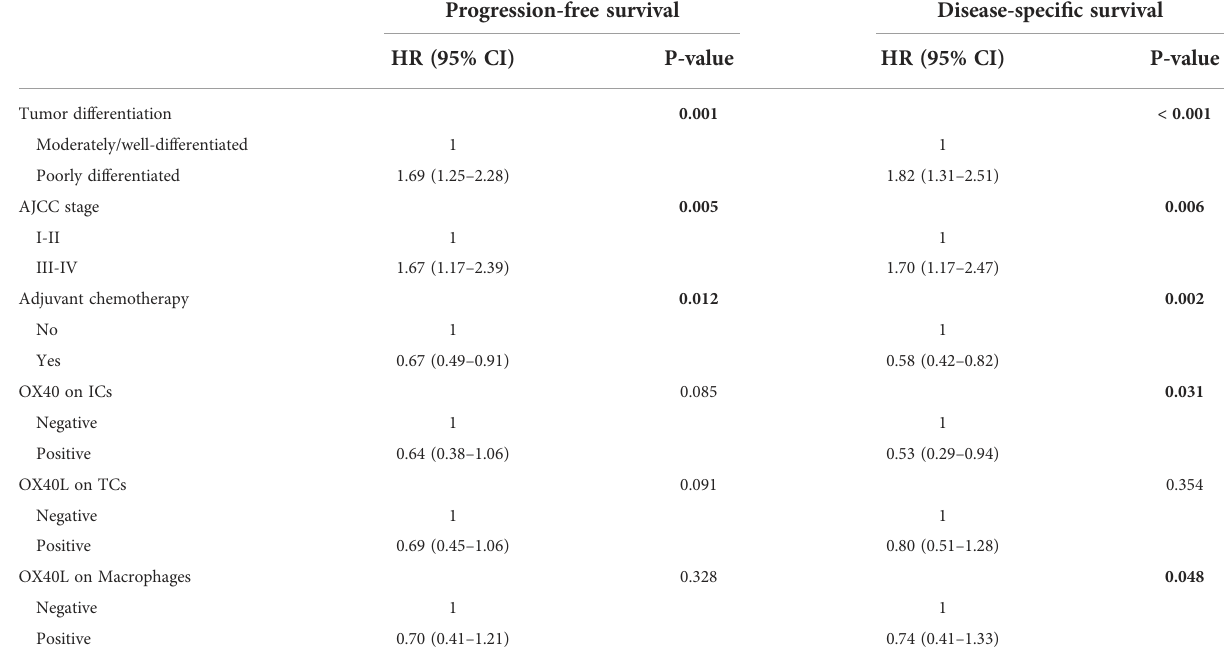
TABLE 2 Multivariate analysis of factors potentially associated with progression-free survival and disease-speci fi c